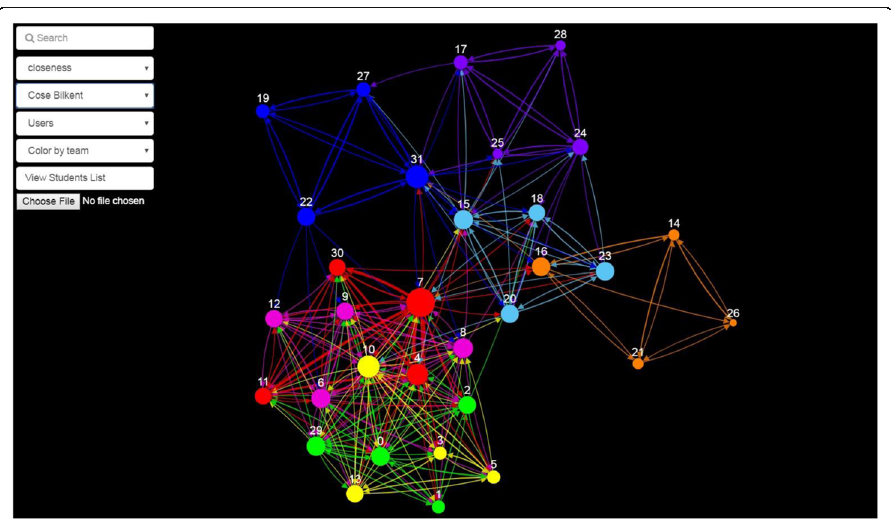
Fig. 3 Visualization provided by StudentViz using Cose-Bilkent plotting method. Nodes ’ diameters are proportional to PageRank metric, while their colors depict affiliation to a specific team . This figure provides the instructor with a general overview of students ’ collaboration and their relative collaboration status. Nodes with a central position and larger diameters depict learners with higher collaboration status. This figure supports VN1 and VN2, as well as P1 and